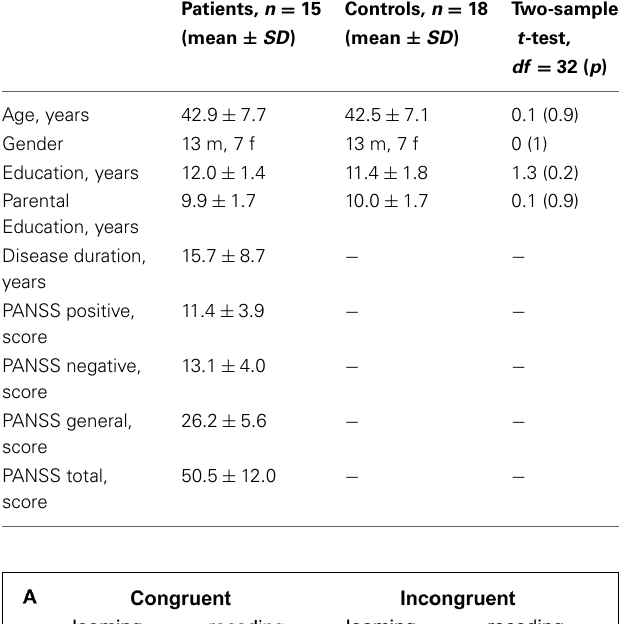
Table 1 | Sociodemographic characteristics of the groups and the illness-related data for the patients.